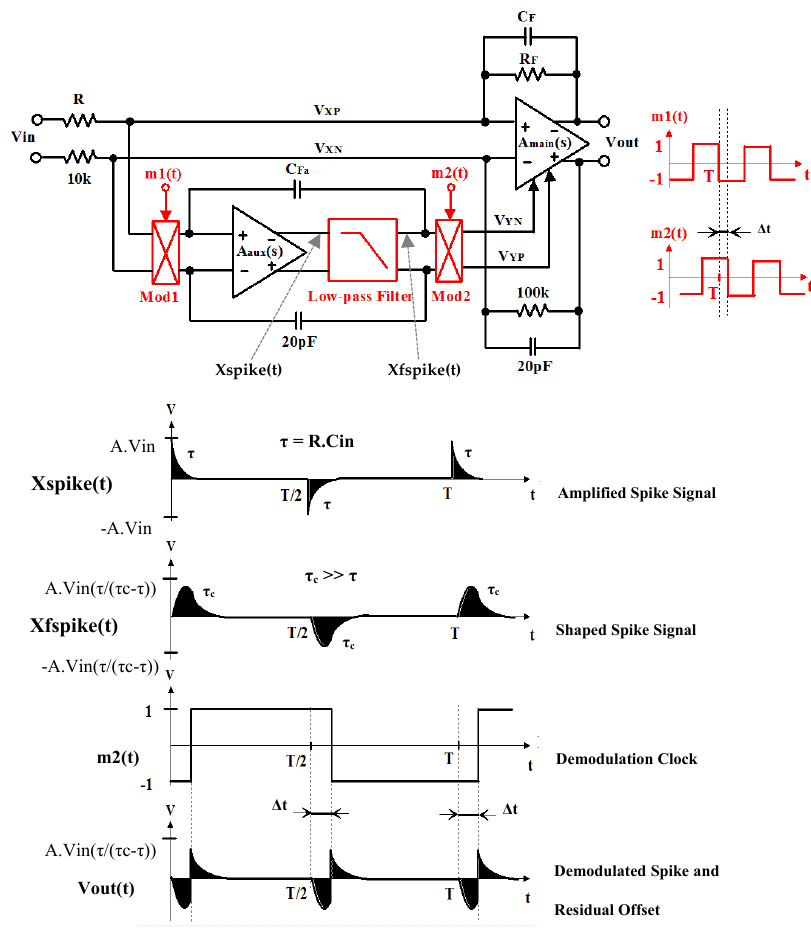
Figure 2. Delay-time chopper stabilization preamplifier.